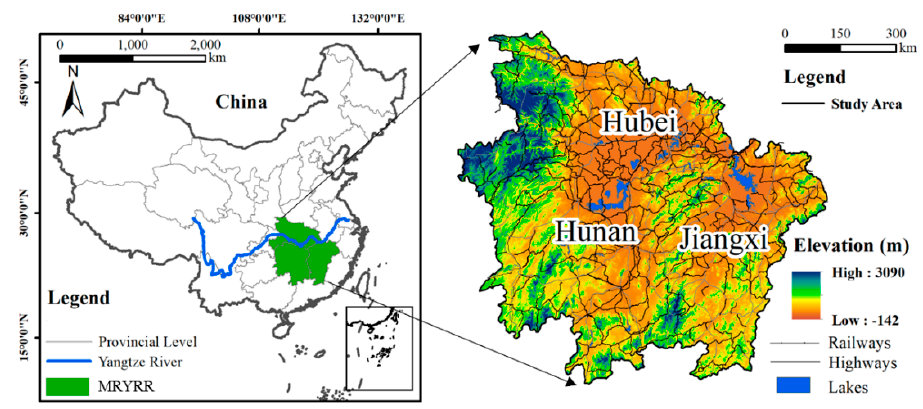
Figure 1. Locations of the MRYRR.